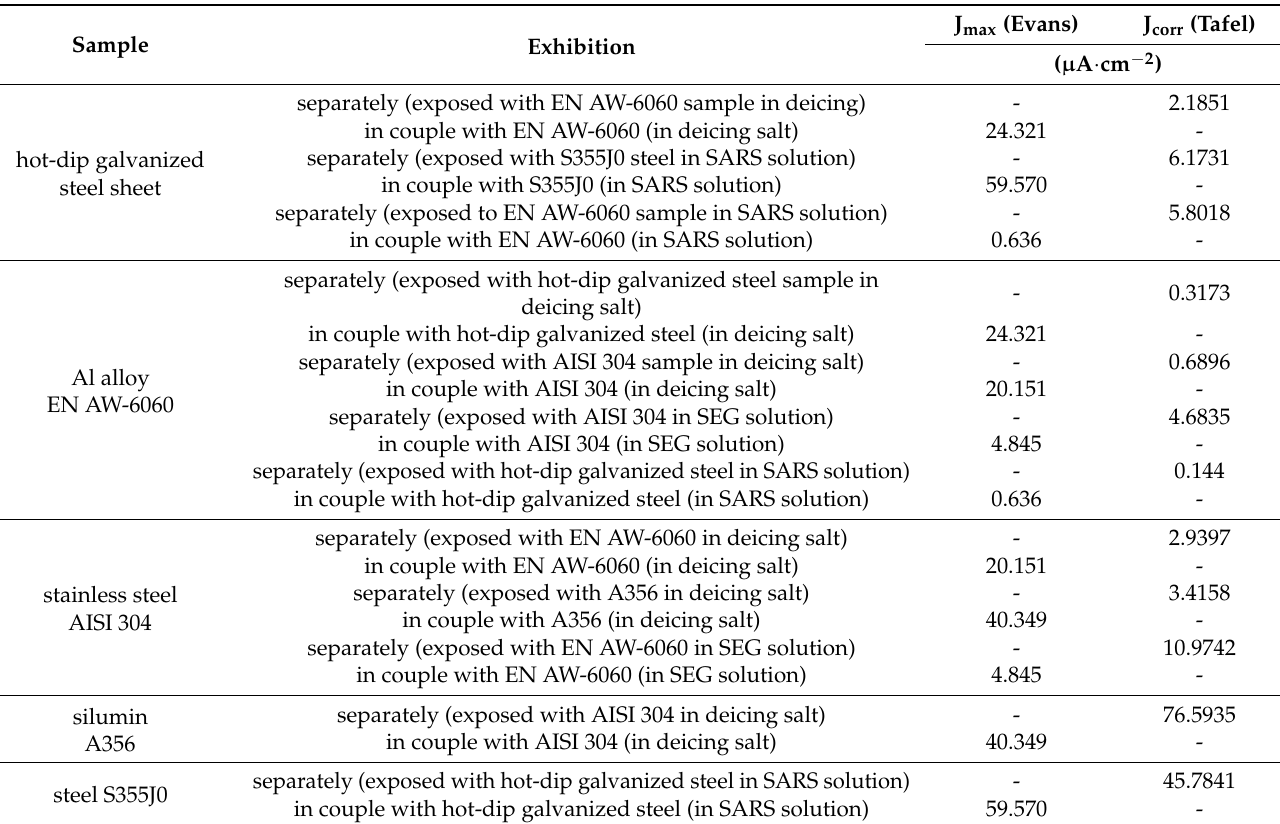
Table 7. Comparison of current density J max measured by Evans and current density J corr measured by Tafel.